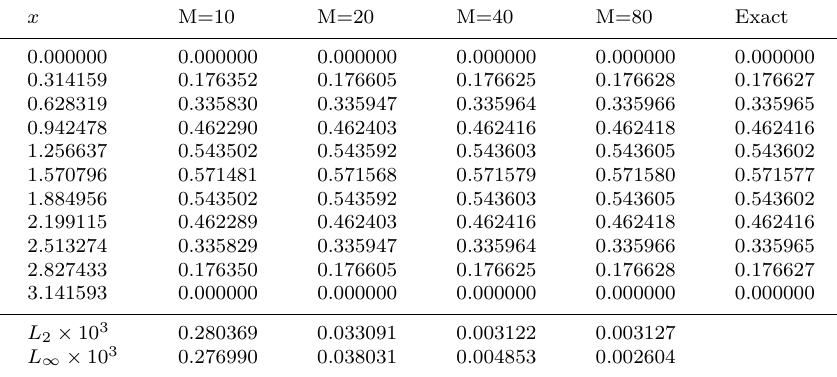
Table 2. The comparison of solutions and error norms of the diffusion problem for γ = 0 . 5, ∆t = 0 . 00007 and t f = 0 . 35.